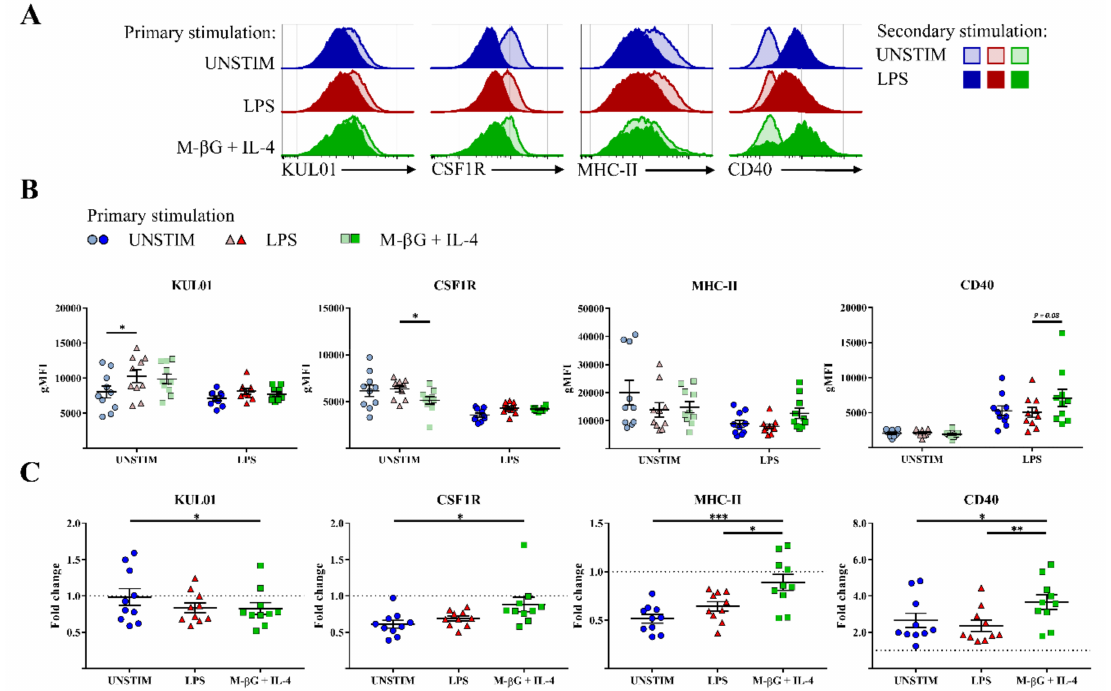
Figure 5. Primary stimulation with β -glucan microparticulates + IL-4 influenced the expression level of cell surface markers on macrophages after secondary stimulation with LPS. Surface expression of KUL01, CSF1R, MHC-II and CD40 was assessed after secondary stimulation with LPS (10 µ g / mL). ( A ) Expression of the markers is shown by histograms for macrophages derived from one representative chicken upon secondary stimulation with LPS or secondary unstimulated cells (UNSTIM). ( B ) The e ff ect of di ff erent primary stimulations after 7 days for secondary unstimulated cells (UNSTIM) and upon secondary stimulation with LPS. The expression of the markers KUL01, CSF1R, MHC-II and CD40 were expressed in geometric mean fluorescent intensity (gMFI). ( C ) The e ff ect of di ff erent primary stimulations on secondary stimulated macrophages for surface expression of KUL01, CSF1R, MHC-II and CD40. The expression of the markers upon secondary stimulation with LPS was compared to secondary unstimulated cells (UNSTIM) and changes were expressed as a fold change in geometric mean fluorescent intensity (gMFI). For ( B , C ), each bar represents mean ± SEM ( N = 10 chickens). * p < 0.05; ** p < 0.01; *** p <